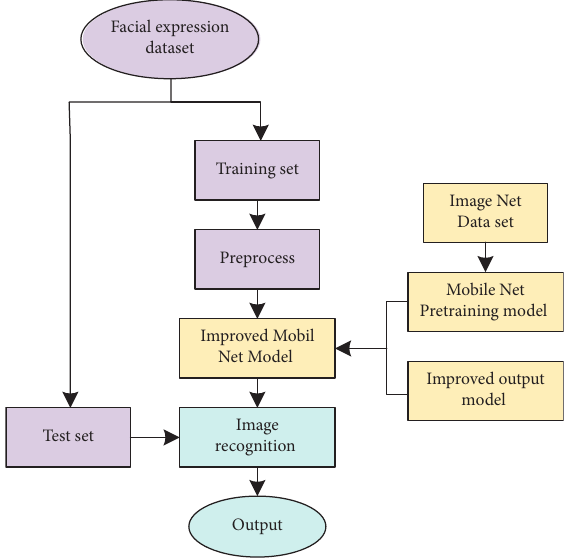
Figure 1: Overall framework of the proposed